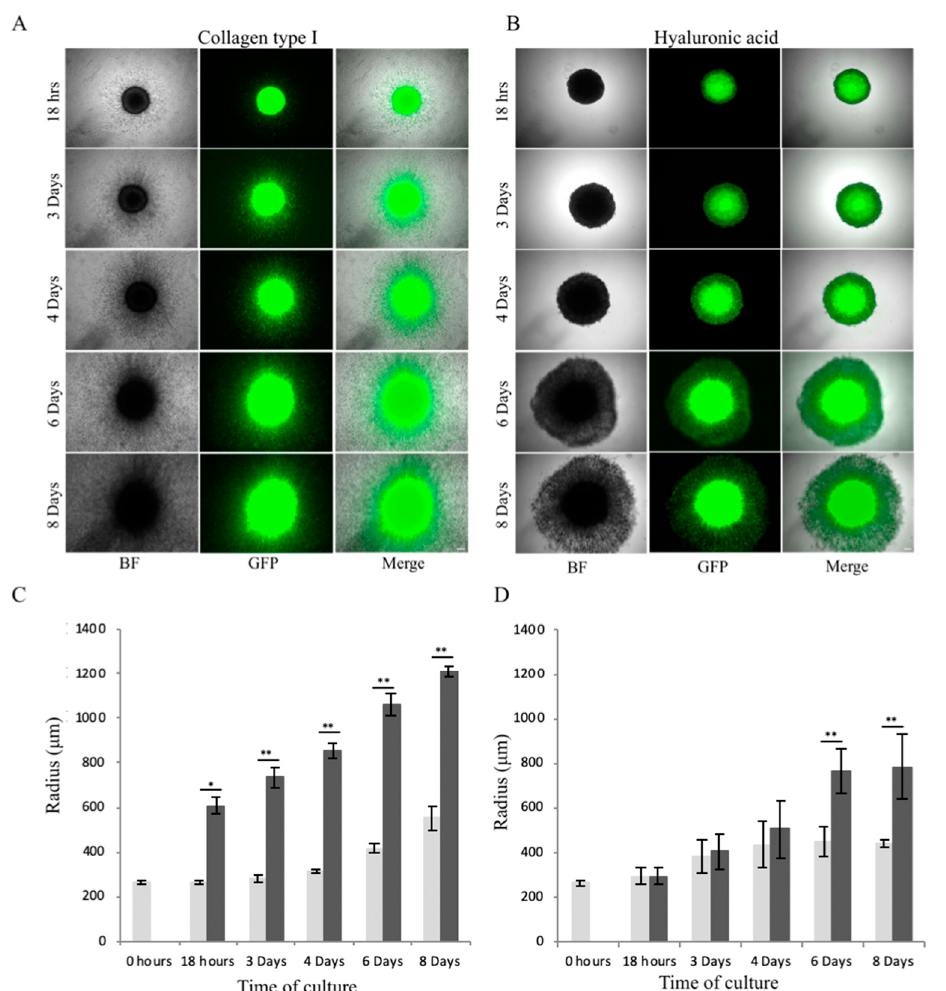
Figure 9. Behavior of glioblastoma type IV spheroids in hydrogels. ( A , B ) Microscopy images—bright field (BF), fluorescent (GFP), and merged—of U87-MG GFP + spheroids documenting tumor growth over time COL and HA, respectively. The tumor mass appears as a dense (high fluorescence intensity) inner portion—core—surrounded by a lighter (low fluorescence intensity) outer portion—infiltrating region (scale bar = 50 µ m). ( C , D ) Tumor spheroid progression over time, expressed in terms of overall radius of the tumor mass (grey bars) and radial dimension of the infiltrating region (dark bars) for COL and HA, respectively. Statistical analysis was done using t -test multiple comparison with a confidence level of 95% ( p < 0.05). GraphPad was